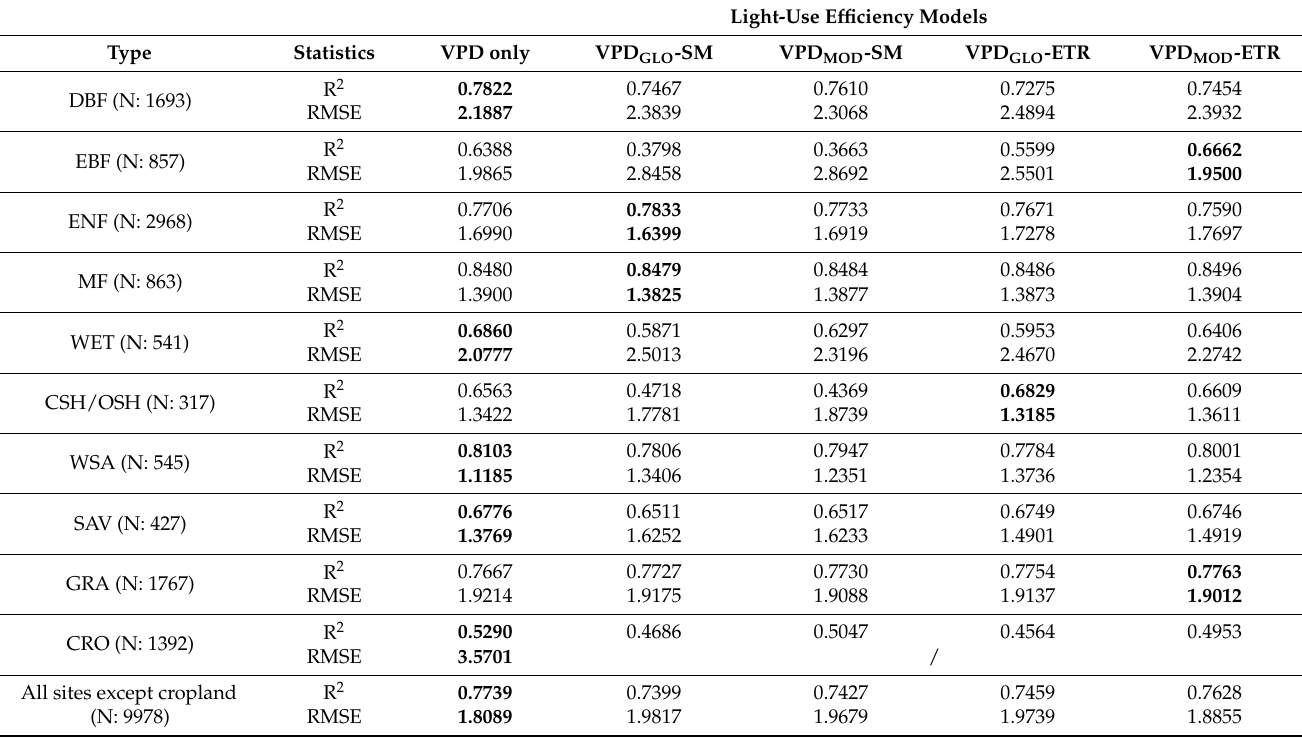
Table 1. Regression statistics for different light-use efficiency models between each land-use type’s measured FLUXNET GPP and LUE